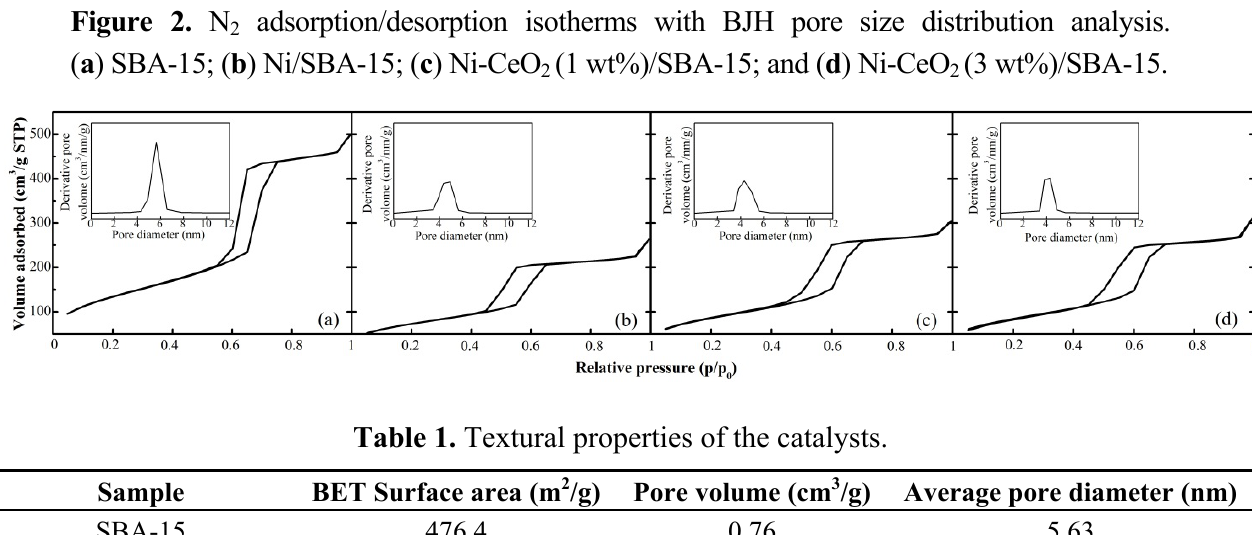
Figure 2. N adsorption/desorption isotherms with BJH pore size distribution analysis. 2